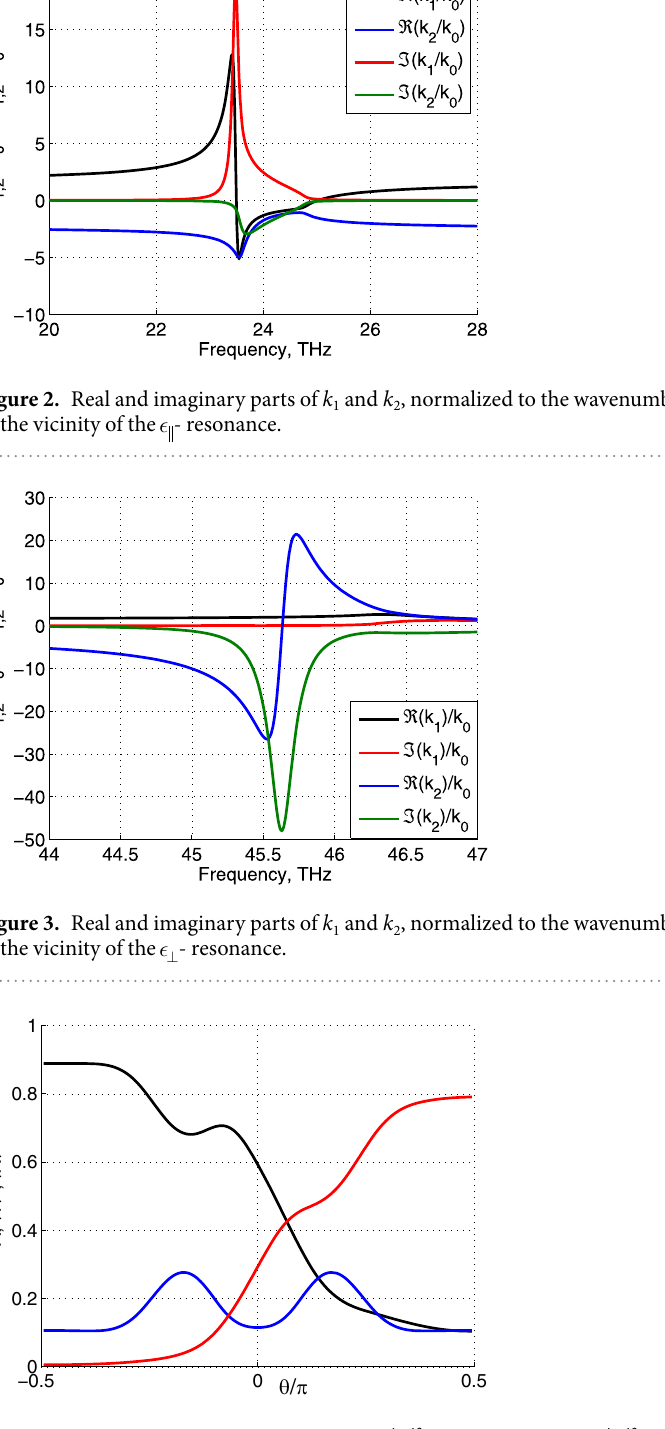
Figure 4. Absorption A (black), transmission | T | 2 (red) and reflection | R | 2 (blue) of the plane wave incident onto the slab of orthorhombic boron nitride versus the incidence angle θ [rad]. The thickness of the layer h is 1.5 μ m and the tilt angle φ =